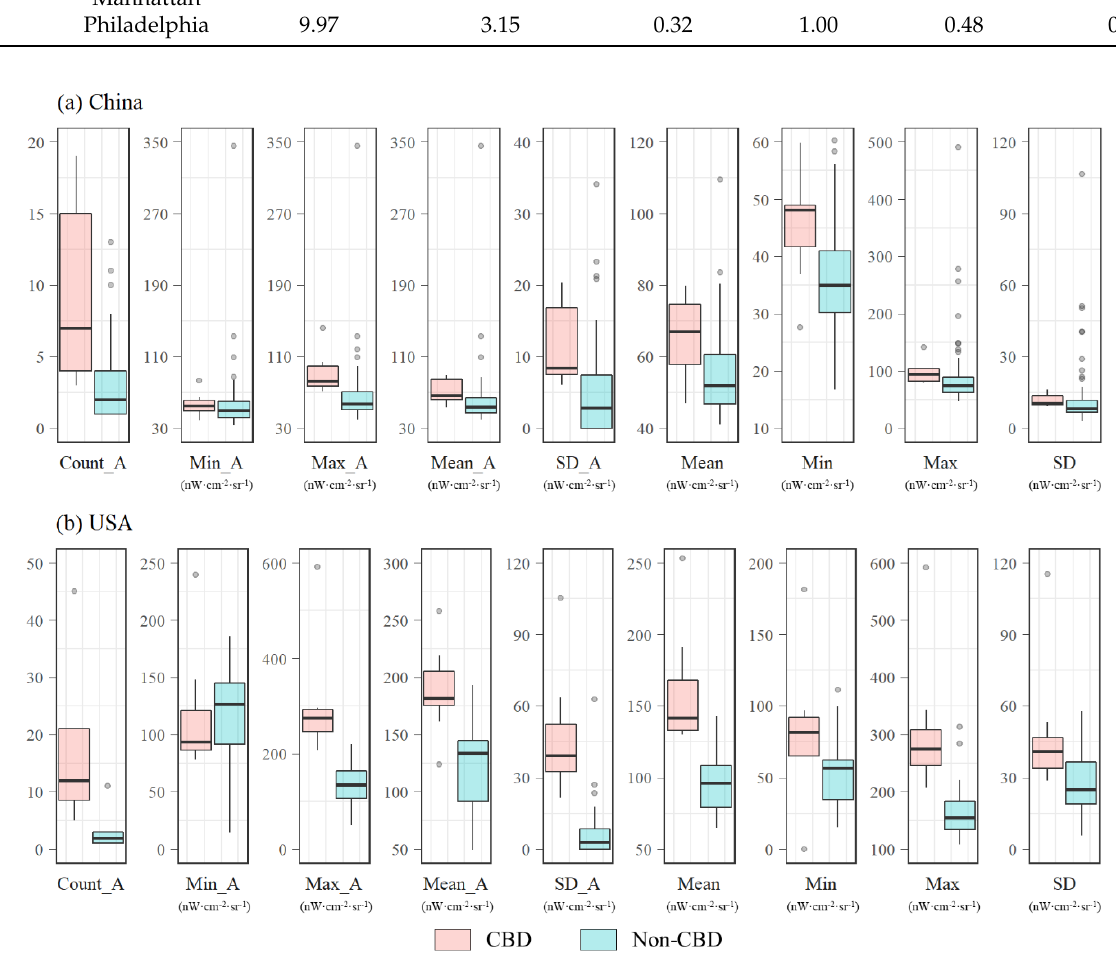
Figure 7. The boxplots of nine indexes are based on PAAs of CBD and Non-CBD. (a-b) The boxplots of China and the USA. Table 5. Accuracy assessment of China rules and the USA rules. Expressed in the number of PAAs.